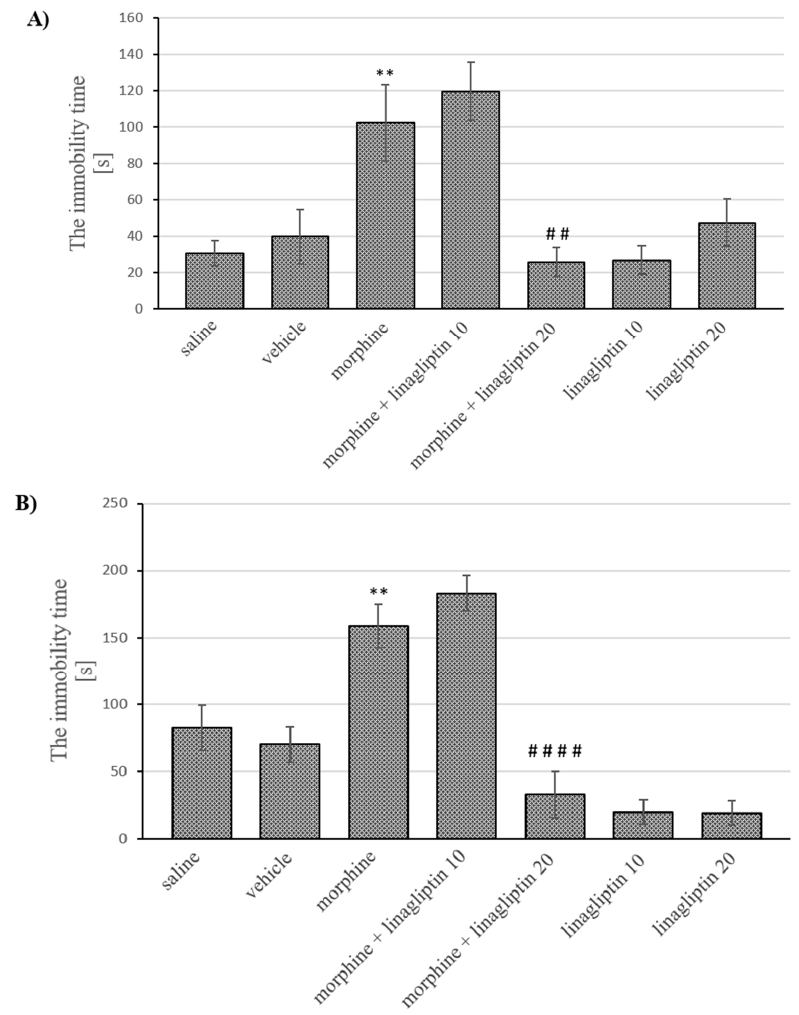
Figure 4. The influence of linagliptin (10 and 20 mg/kg, ip) administered during morphine with- drawal on depressive behavior observed in mice, in the forced swim test, after: ( A ) short-term (60 h) and ( B ) long-term (14 days) morphine withdrawal. Morphine was administered twice a day for eight consecutive days (10, 15, 20, 25, 30, 35, 40 and 50 mg/kg, ip). Linagliptin was injected once a day,